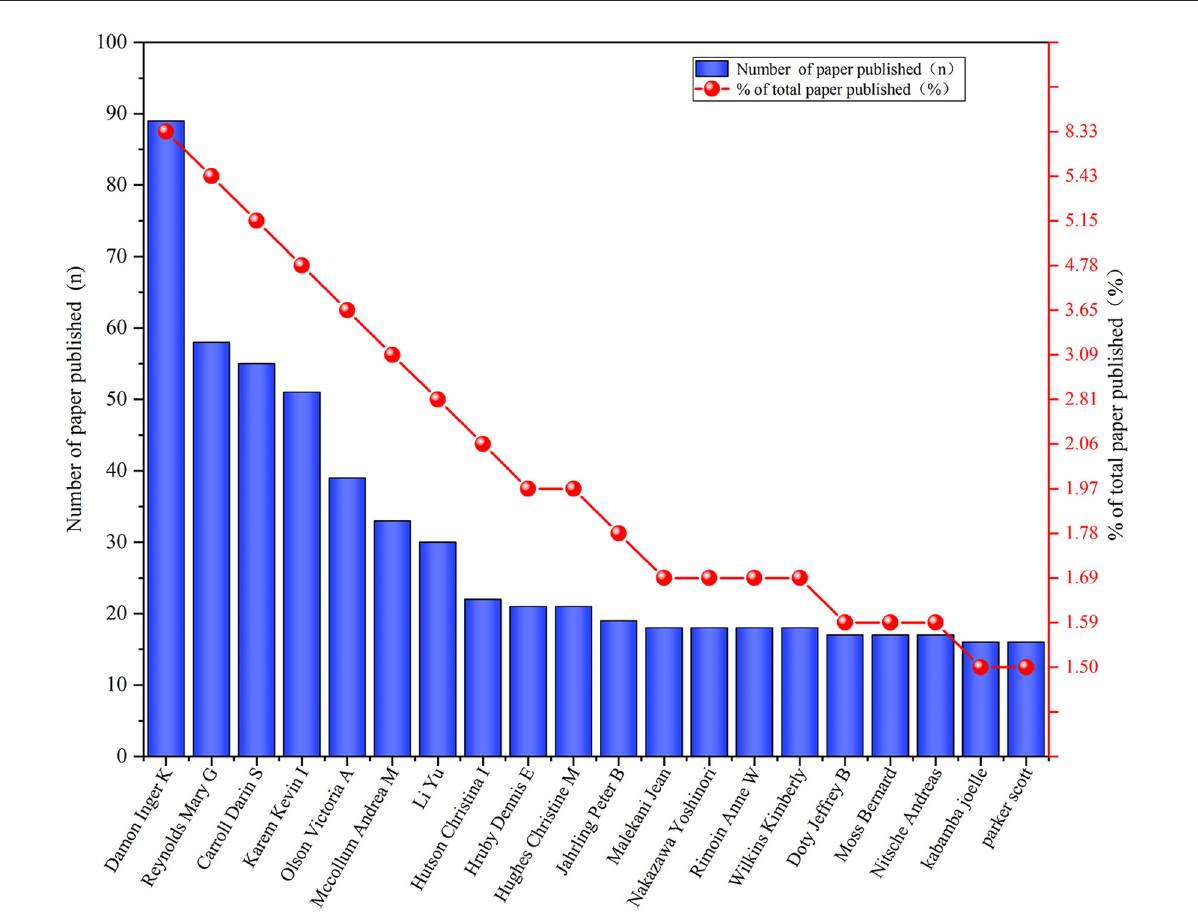
FIGURE4 Top 20 authors with most published papers in the field of monkeypox. The Y-axis on the left indicated the number of publication and the right indicated the proportion of the total number.